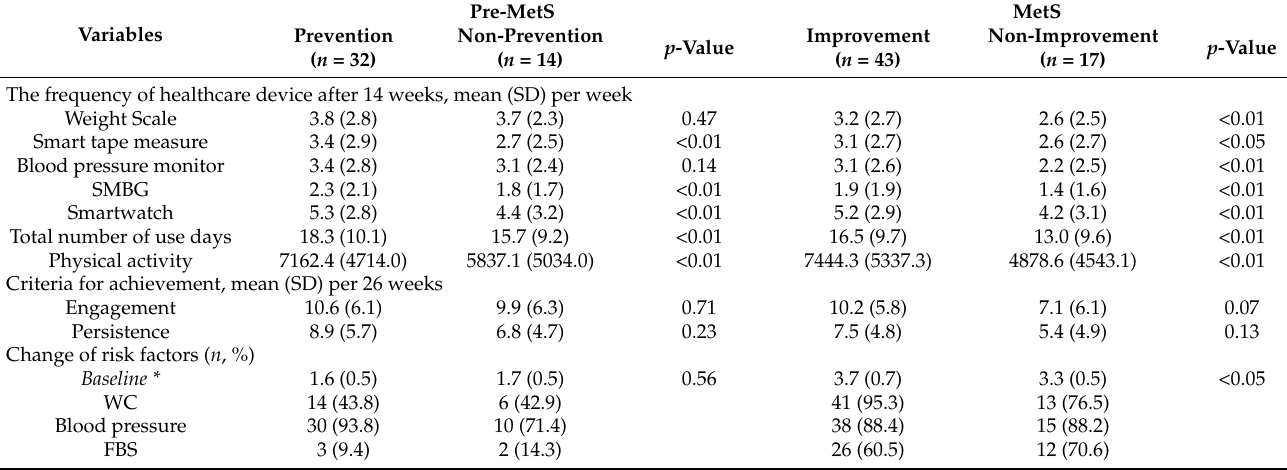
Table 2. Engagement differences between the